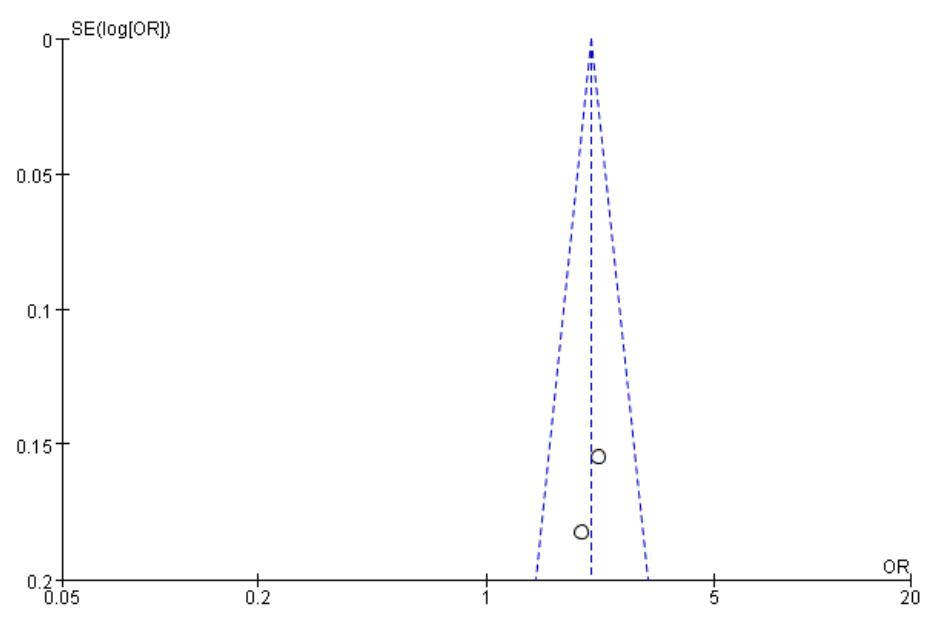
Figure 13. The funnel plot of publication bias for the region for flatfoot in children.